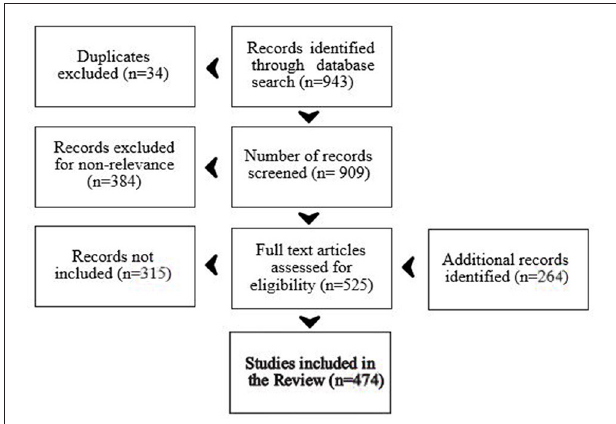
FIGURE 1 | Processing of